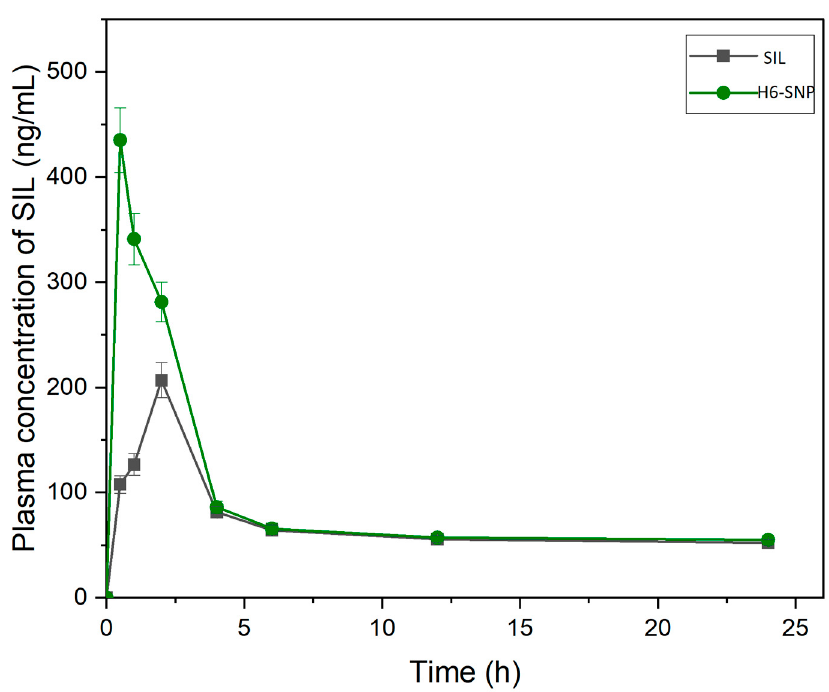
Figure 15. In vivo pharmacokinetic plasma concentration vs. time profile of SIL vs. H6-SNP (mean ± SD; n = 6).